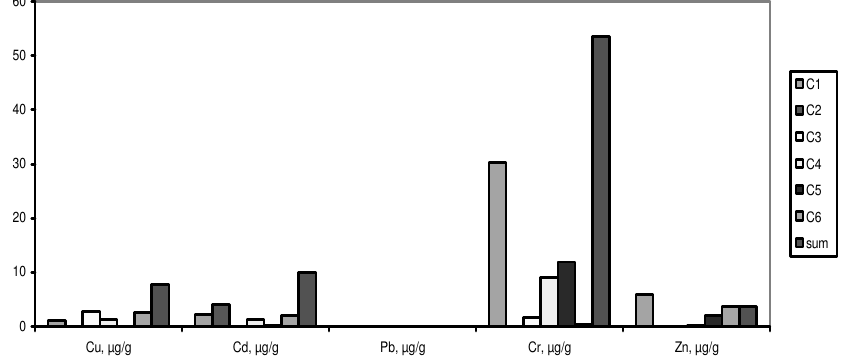
Figure 1. Concentration of heavy metals in crabs collected for a period of six weeks.